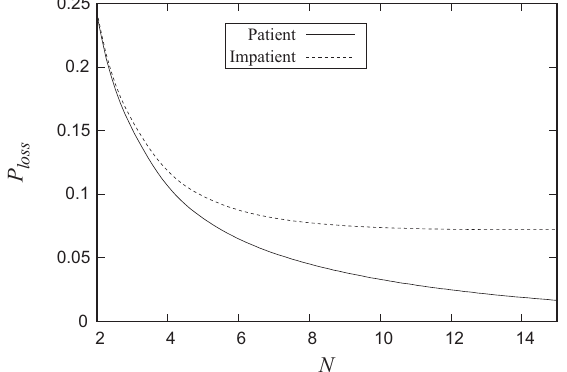
Figure 10. Dependence of the probability P loss on the number N .